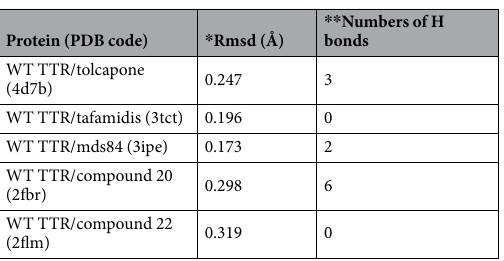
Protein (PDB code)